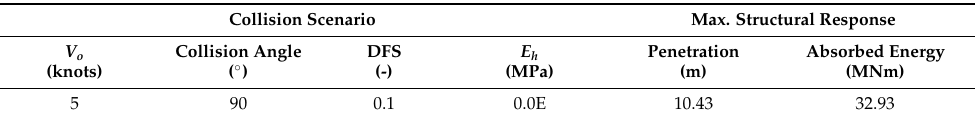
Table 6. Collision scenario and maximum structural response obtained by Kim et al. (reproduced from [21], with permission from Elsevier 2022).